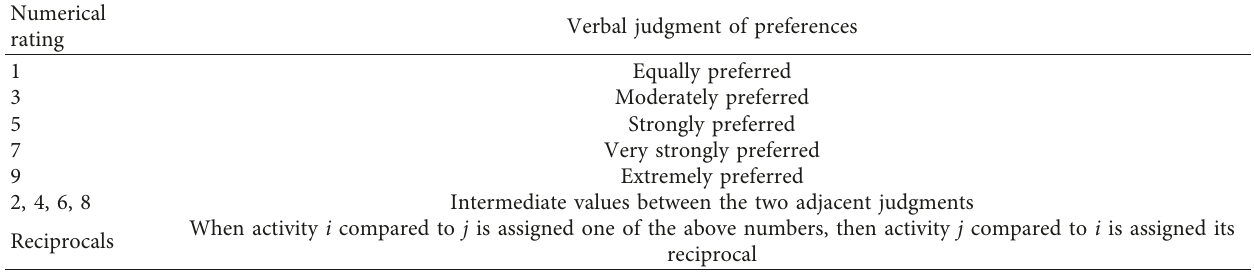
Table 1: Pair-wise comparison scale for AHP preferences.